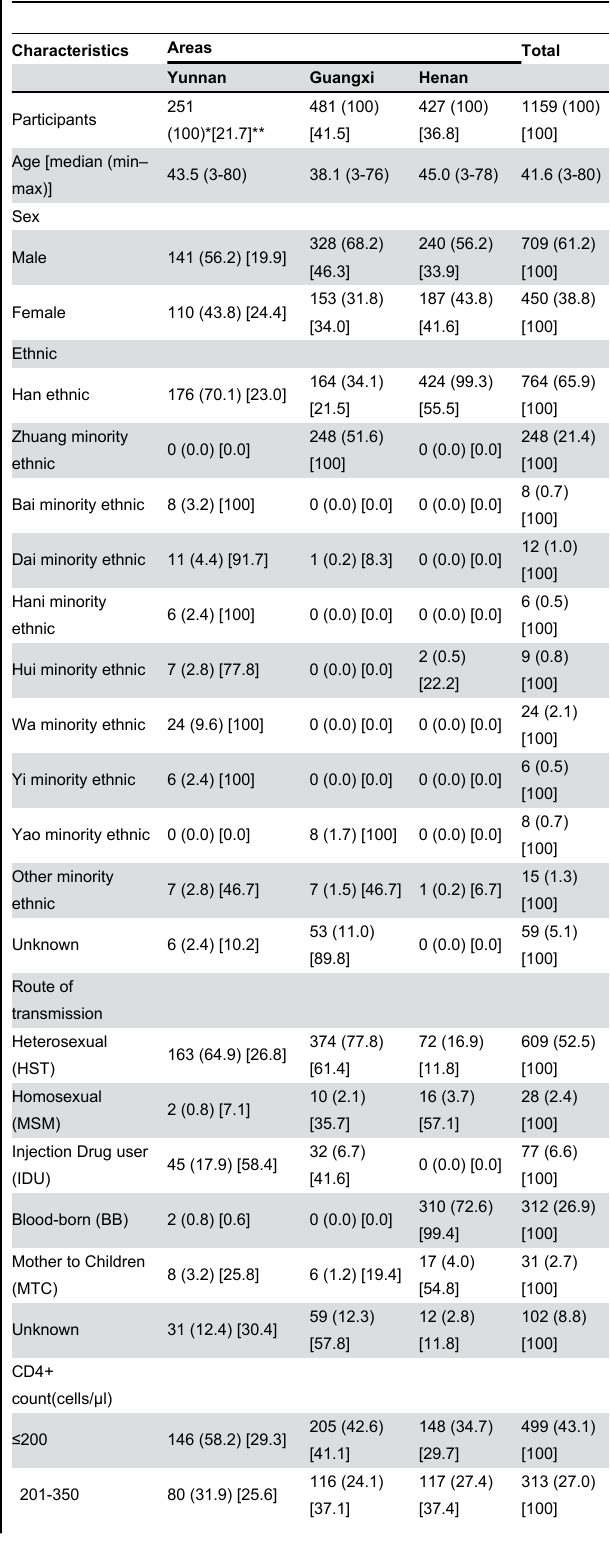
Table 1. Characteristics of treatment-naïve HIV-1 infected participants with pol